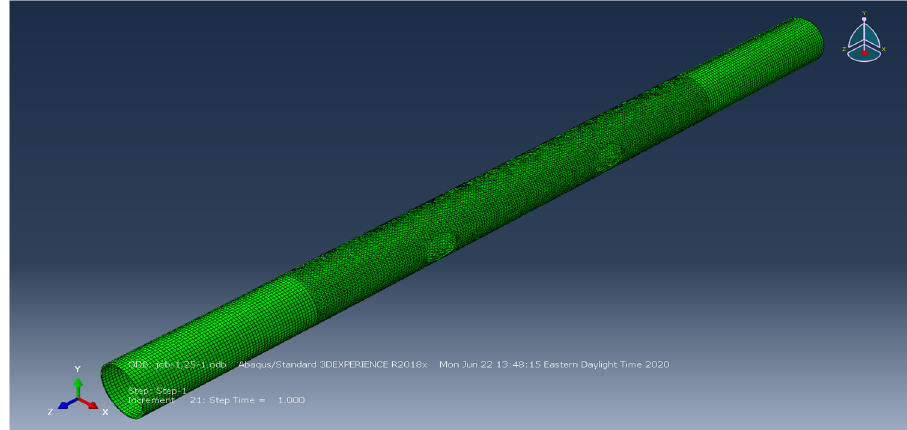
Figure 7. Overall FE model of 1.5-1.